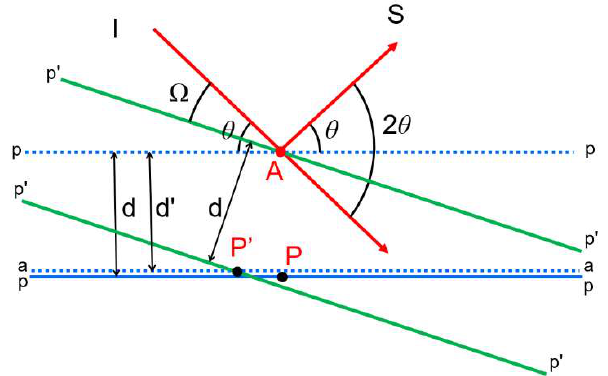
Figure 4. The atoms A and P sit on the planes pp and scatter radially. The scattering is at a maximum when the Bragg condition is satisfied, i.e., the distance between atoms on these parallel planes = λ/(2sin θ B ). If the condition is satisfied when A and P scatter in phase d = λ/(2sin θ B ), then any point along pp will be in-phase with A. When the crystal planes are rotated to p′p′ the incident angle becomes Ω and P rotates to the position P′. Following the argument above, P′ now sits on a plane aa that is a distance d′ from A. A and P′ are in-phase when θ = sin −1 (λ/(2d′)), and for large movements in Ω the change in d is very small, such that θ barely changes.